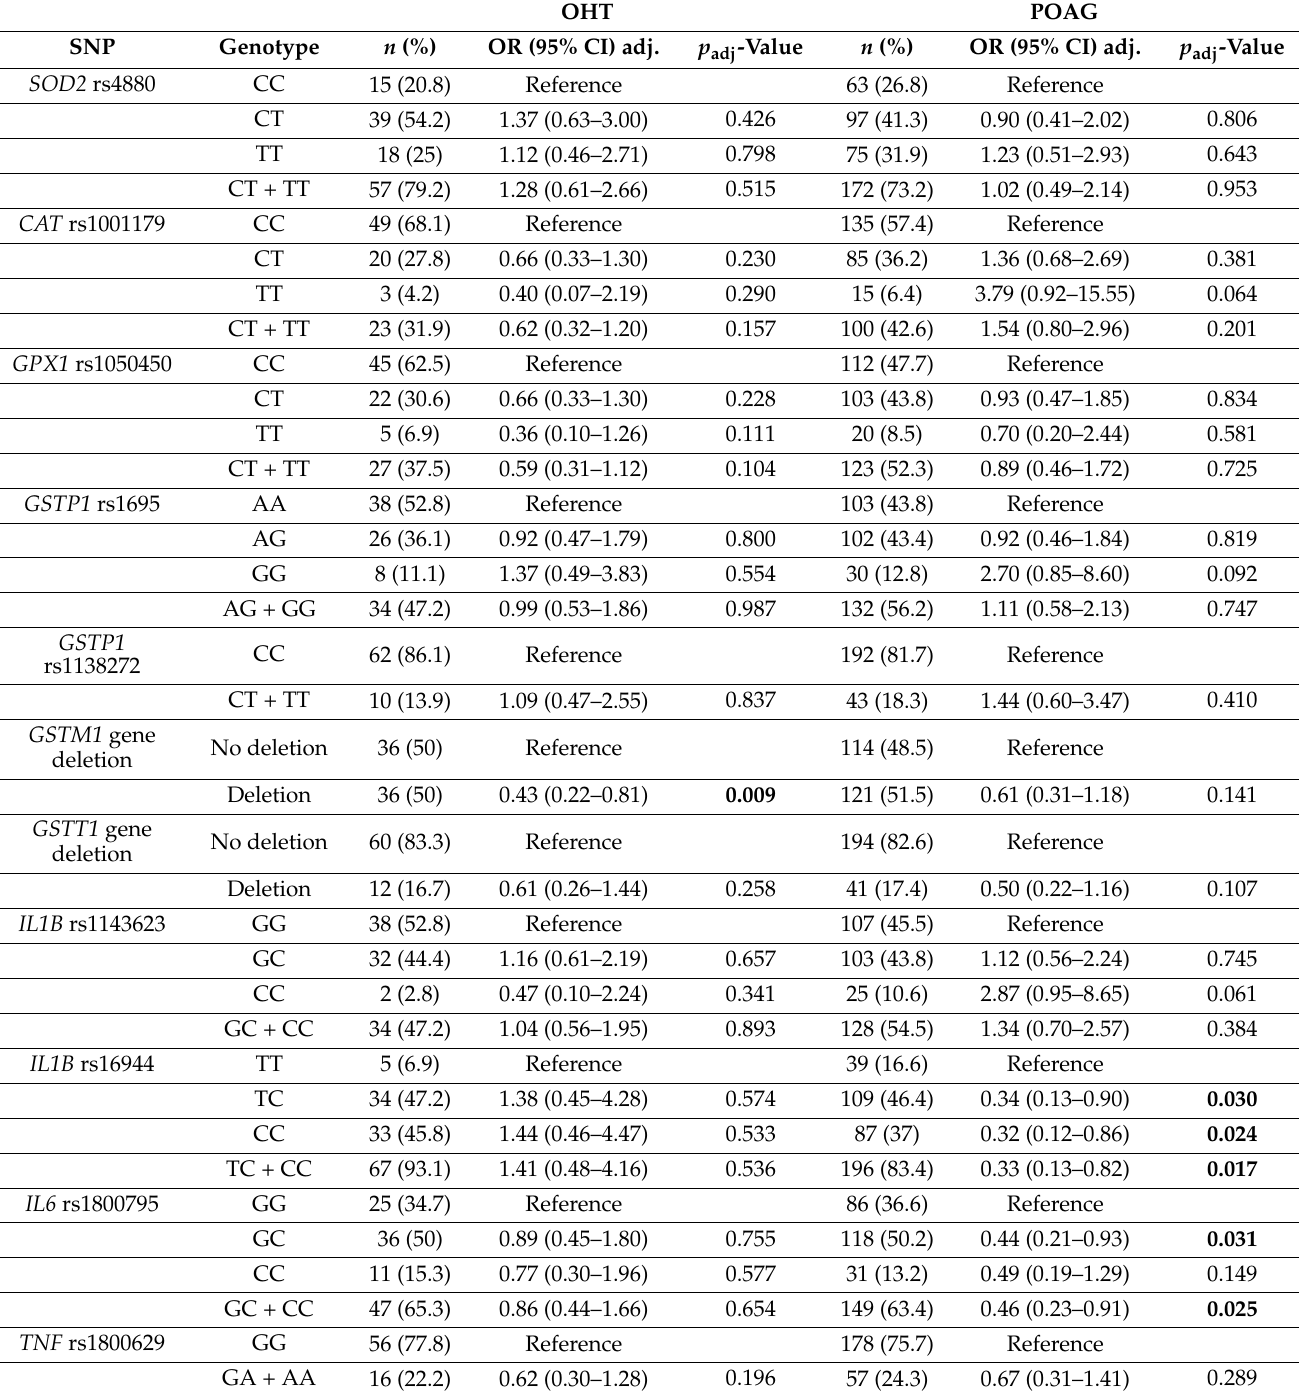
Table 3. Genotype frequencies of selected polymorphisms and their association with the risk of OHT ( n = 72) and POAG ( n =